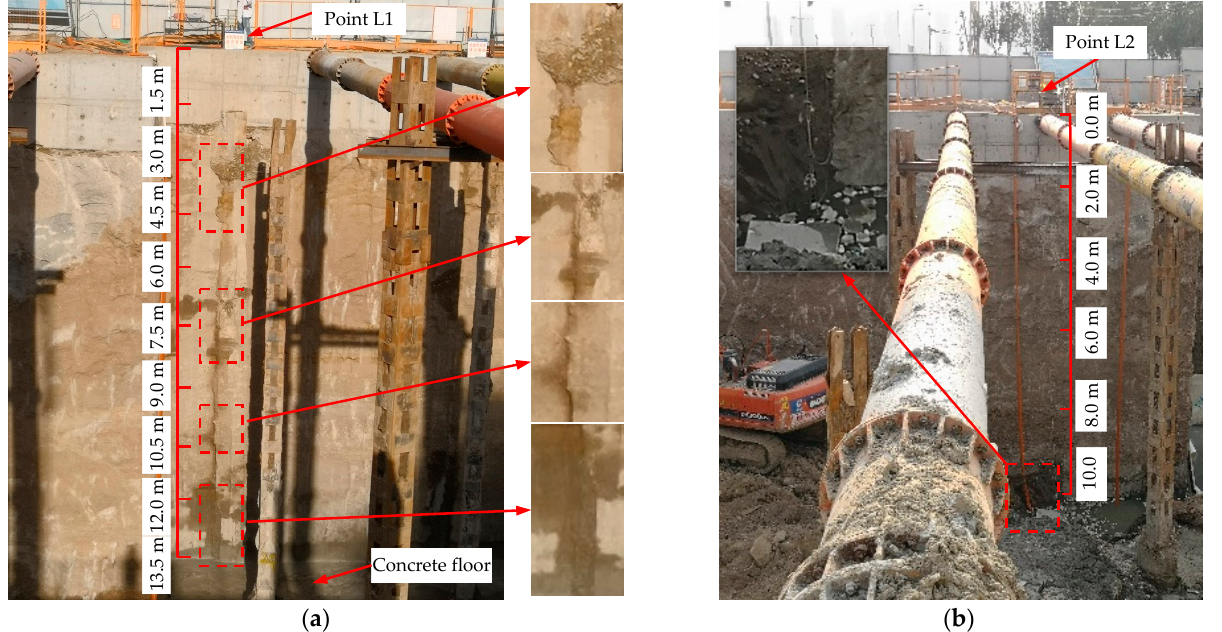
Figure 13. Leakage occurring in the wall joint after finishing excavation. ( a ) leakage occurring at L1; ( b ) leakage occurring at L2. Table 1. Comparison of leakages between predictions and field observations.